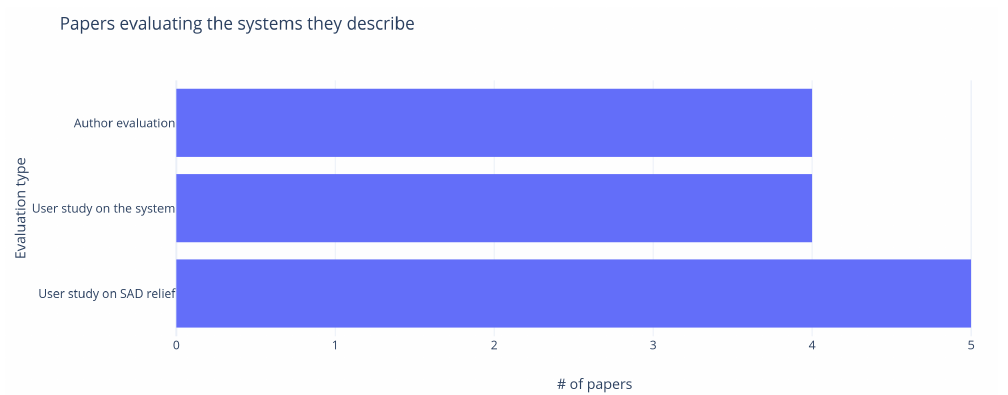
Figure 8. Papers with different system